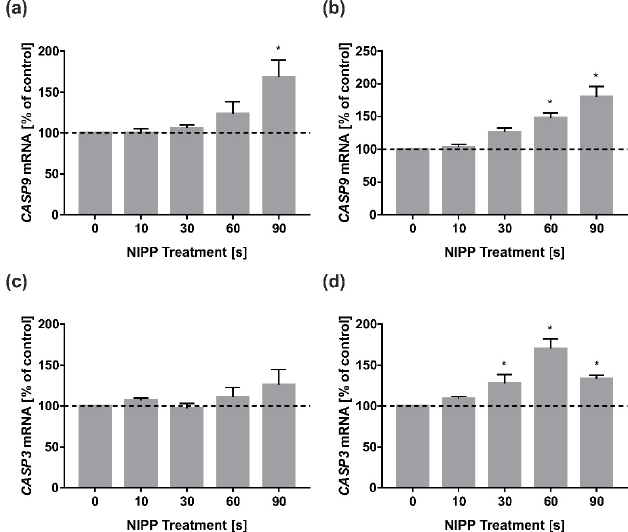
Figure 5. Influence of NIPP on CASP9 and CASP3 mRNA levels in HGF and HGK at 24 h. Treatment was performed for the indicated times: ( a ) CASP9 mRNA in HGF; ( b ) CASP9 mRNA in HGK; ( c ) CASP3 mRNA in HGF; ( d ) CASP3 mRNA in HGK. n = 9. * statistical significance compared to control (0 s) ( p <